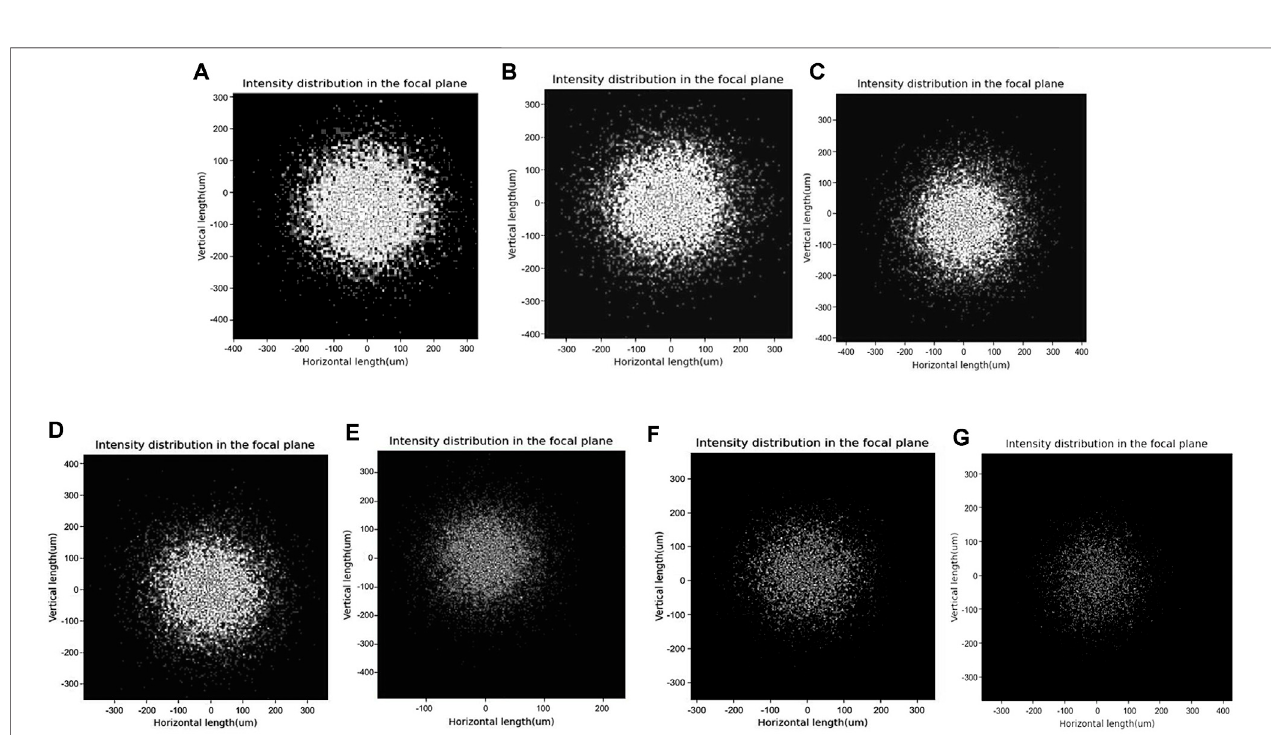
FIGURE4| Intensity of the reconstructed image at the focal plane by CCD camera. (A) VL + VL (B) LC + RC (C) LC + LC (D) VL + VE (E) VL + HE (F) VE + HL (G) VL + HL.